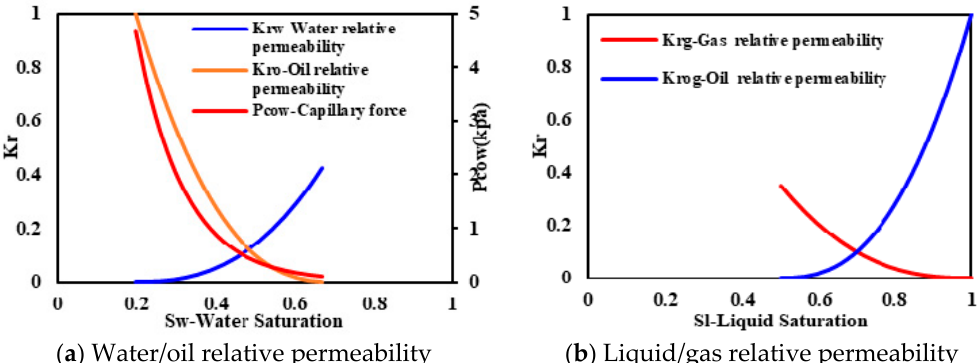
Figure 6. Relative permeability curve of the matrix.